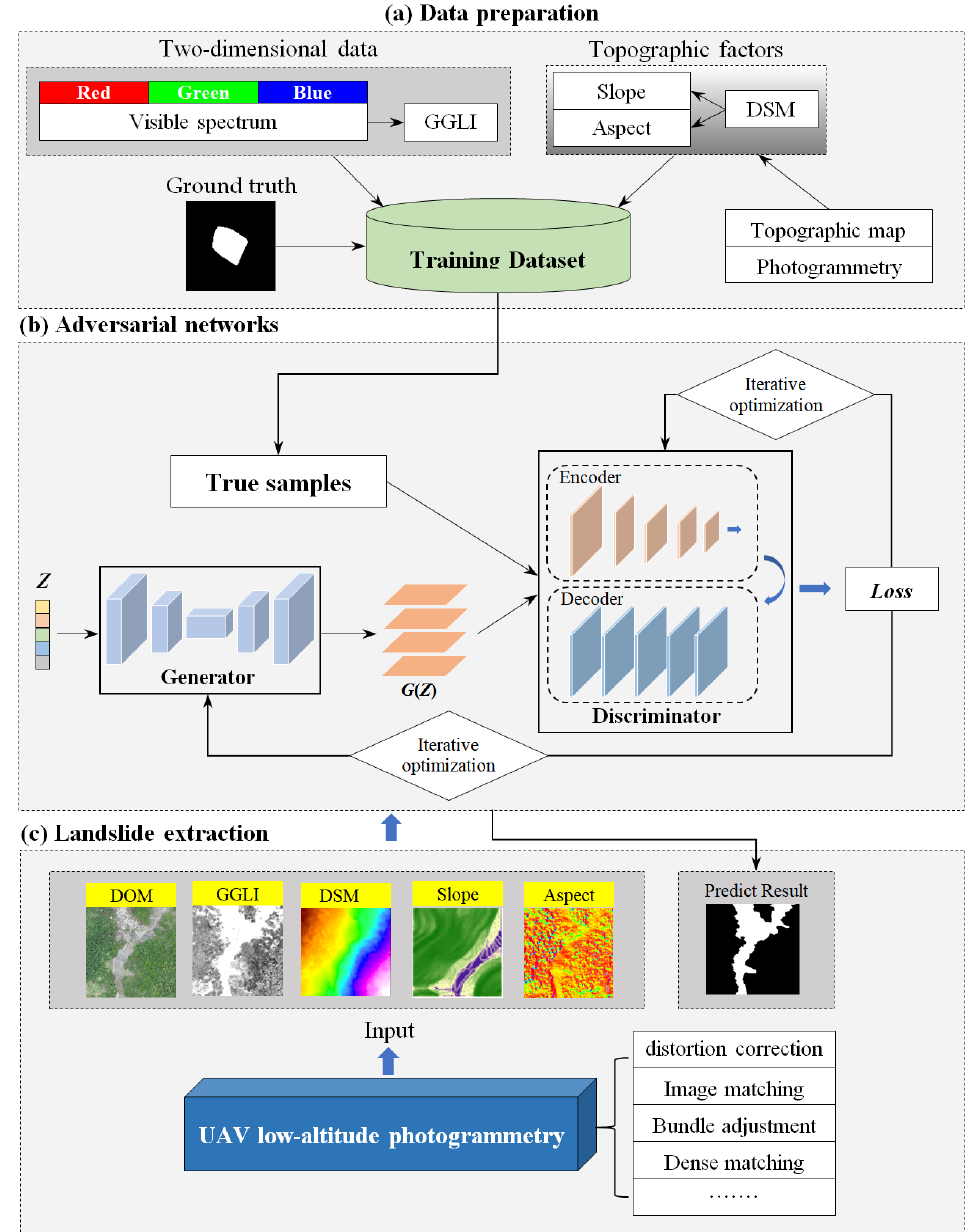
Figure 1. Workflow of the proposed method. ( a ) Data preparation; ( b ) Adversarial networks including generator and discriminator; ( c ) Landslide extraction from UAV-photogrammetry-derived data.